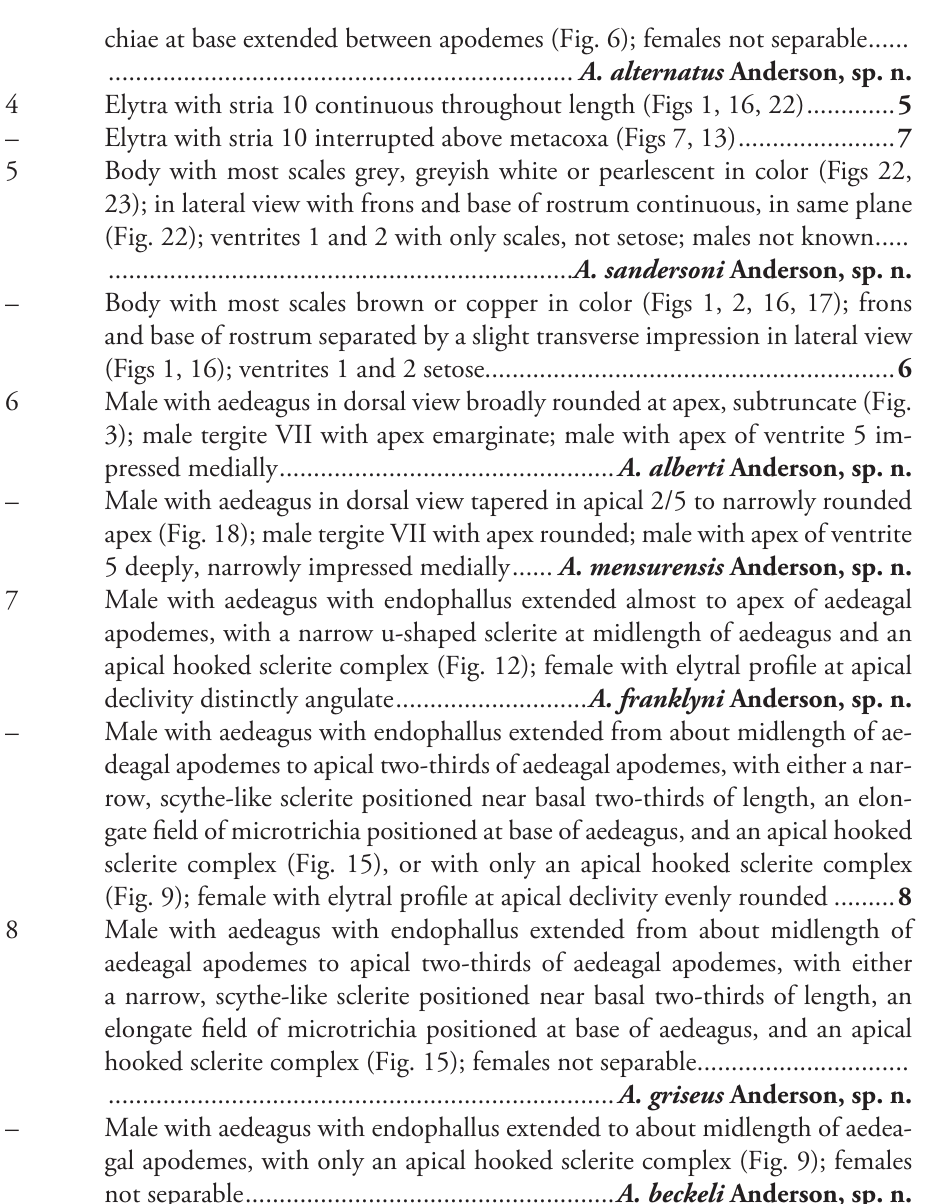
Male with aedeagus with endophallus extended from about midlength of aedeagal apodemes to apical two-thirds of aedeagal apodemes, with either a narrow, scythe-like sclerite positioned near basal two-thirds of length, an elongate field of microtrichia positioned at base of aedeagus, and an apical hooked sclerite complex (Fig. 15); females not separable